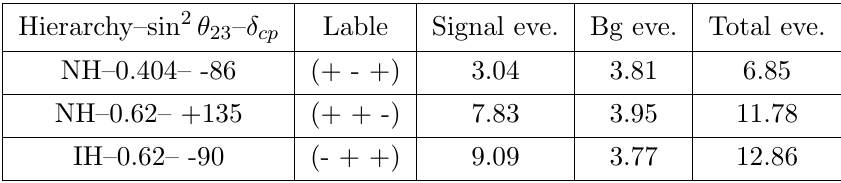
Table 5 . Number of expected (cid:22) (cid:23) e appearance events for one year (cid:22) (cid:23) run of NO (cid:23) A, for the three solutions in ref.